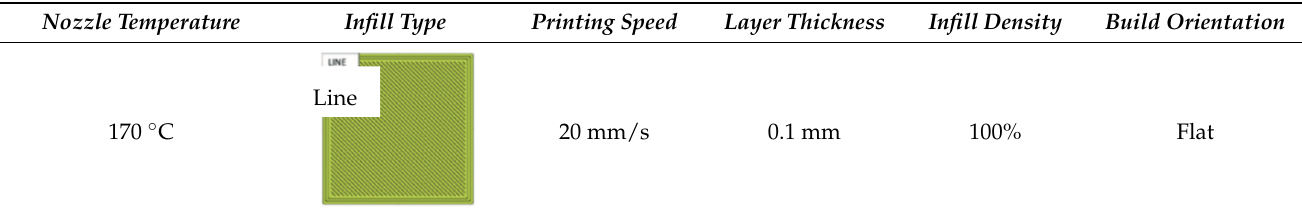
Table 1 . Optimized process parameters combination. Table 1. Optimized process parameters combination.